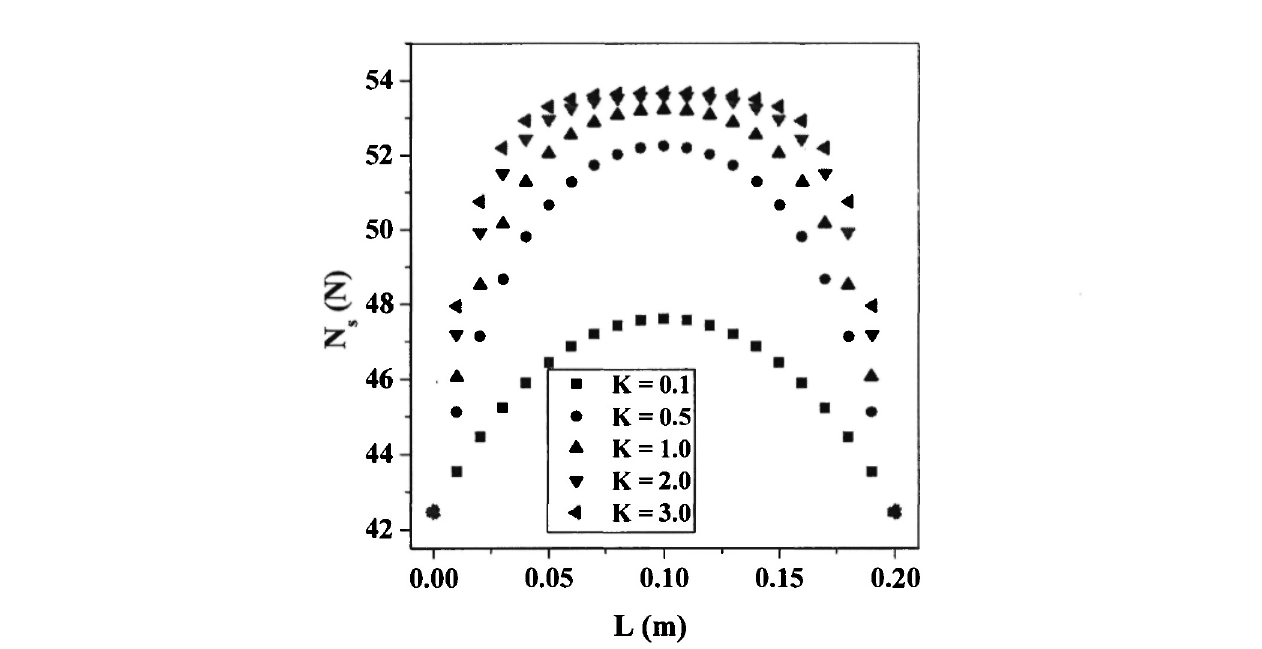
Fig. 8: Skin interfacial force distribution along the length of Al-CFRP sandwich structure, for different values of the interface stiffness.